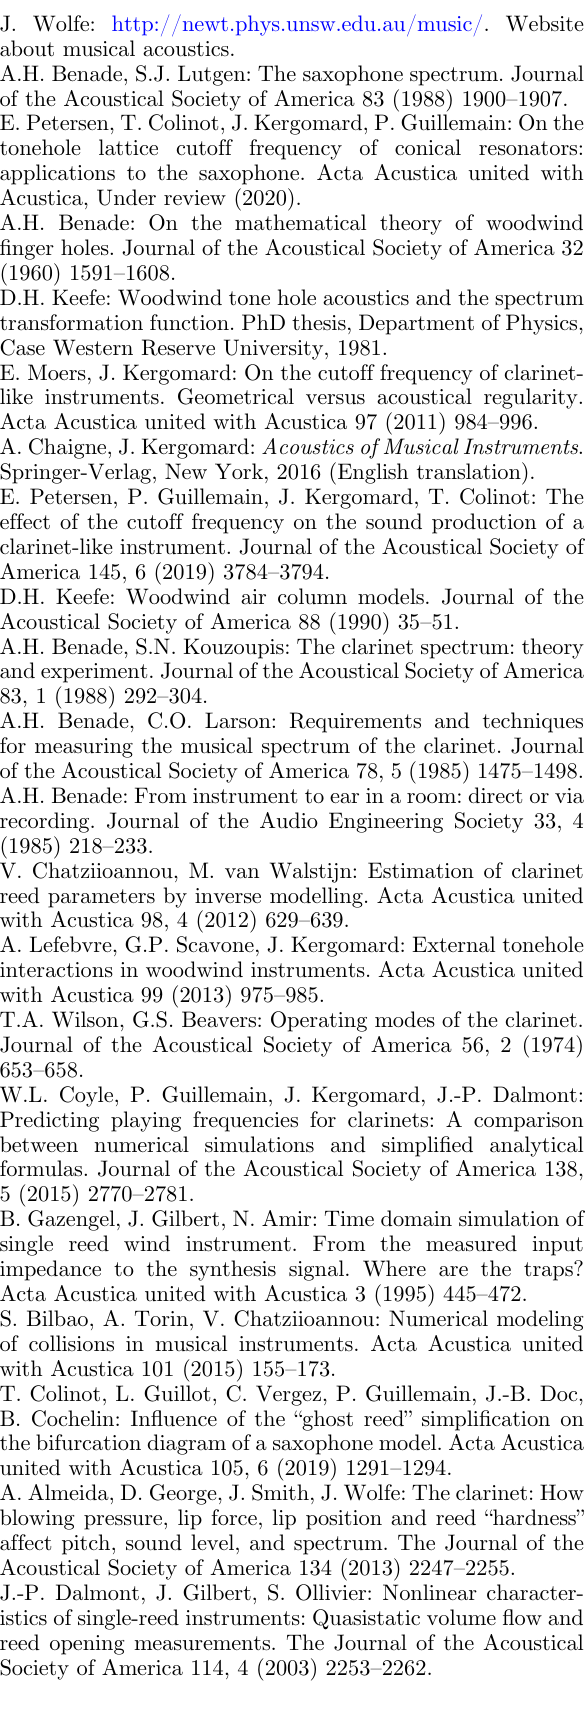
1. Demo1_ScaleByRes.wav : Uses short sections of each note of a resonator to make a rapid scale. Scales from all three resonators play one after the next within the same fi le. This allows for a rapid comparison of the perceptual differences between resonators and across the range of the fi